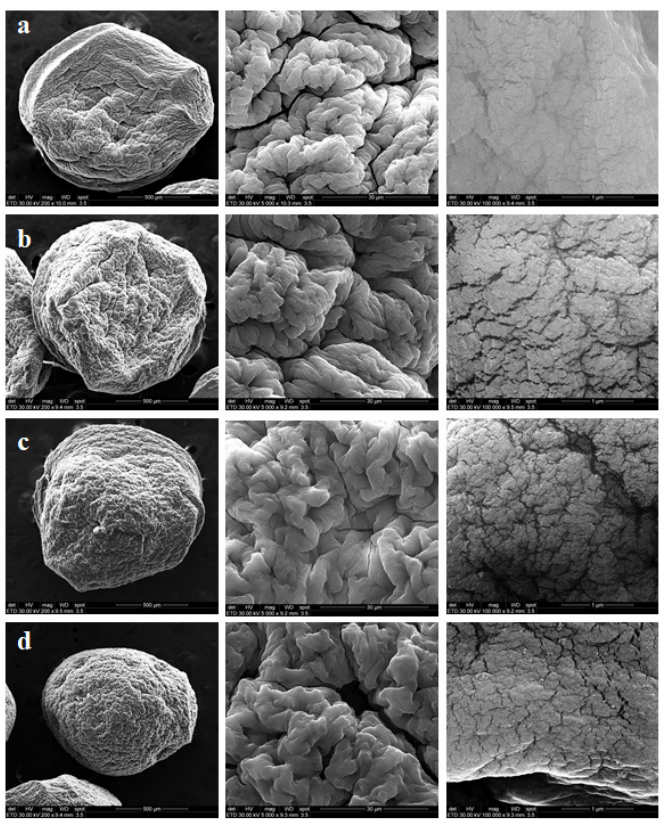
Figure 5. SEM images of the beads with different PCHs concentrations: ( a ) neat NaAlg, ( b ) 1 wt%, ( c ) 3 wt%, and ( d ) 10 wt%. The SEM micrographs reveal that dried hybrid beads based on NaAlg and PCHs were characterized by a rough surface with visible wrinkles and a spherical shape after drying. The SEM images of NaAlg beads indicate a smooth surface that suggests the presence of a uniform structure. The uniform dispersion of PCHs into the core structure of hybrid beads was highlighted by the SEM results. Even at high PCHs concentrations (10 wt%), the clay did not exhibit a tendency to form clusters.